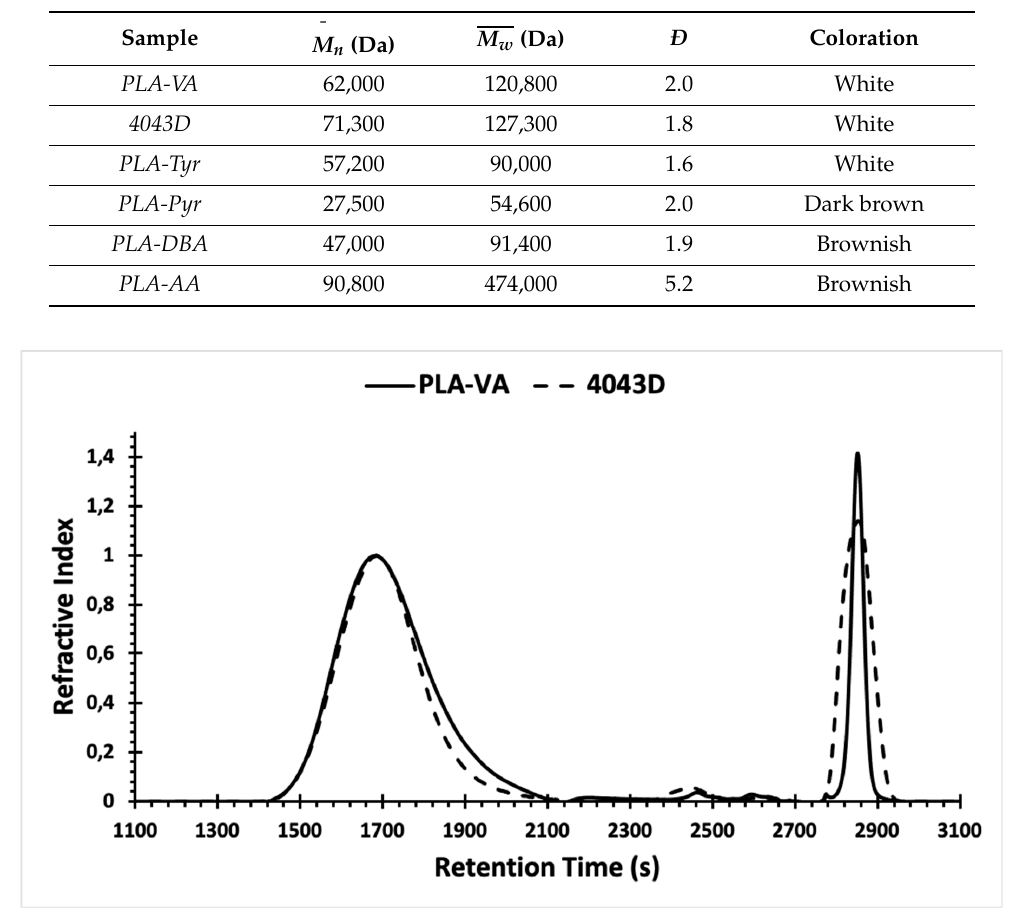
Table 2. Molecular weight data (PS equivalents) according to SEC.